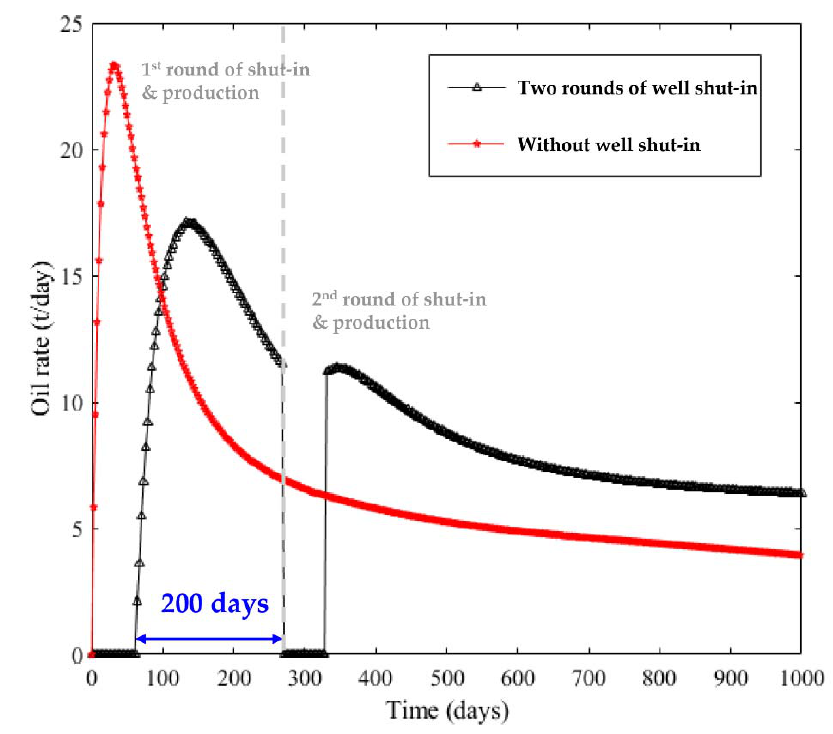
Figure 16. Daily oil rate with 200 days of first round of production.